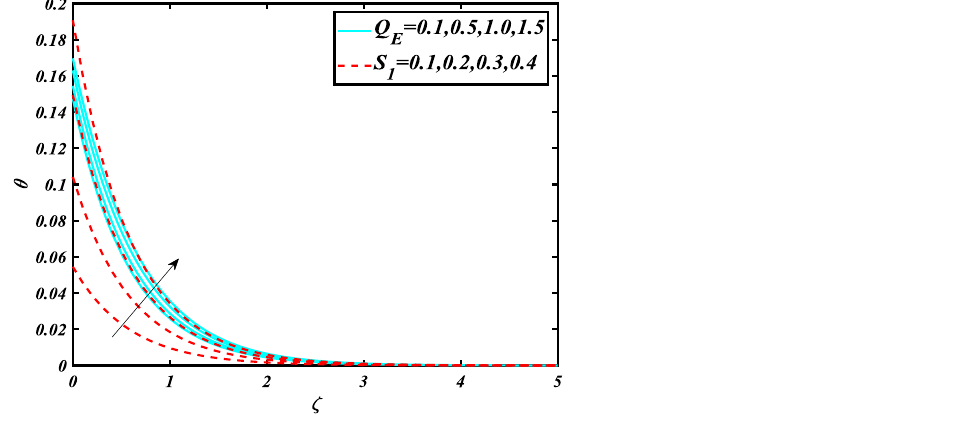
Figure 6. Significance of Q E & S 1 for θ .